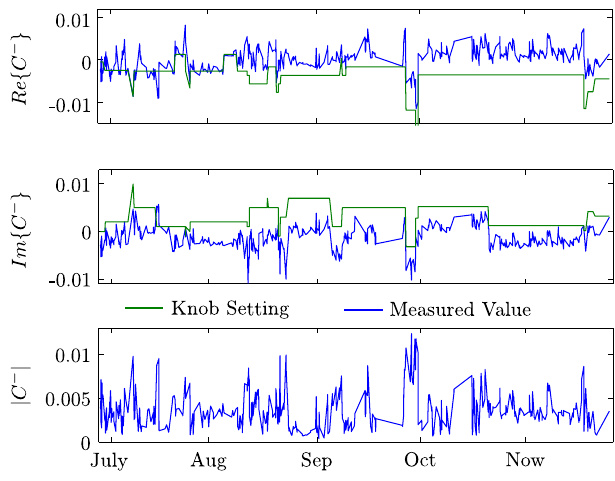
FIG. 6. The variation of the C − from July 2012 until December 2012. The green lines shows the setting of the coupling knobs used and the blue shows the